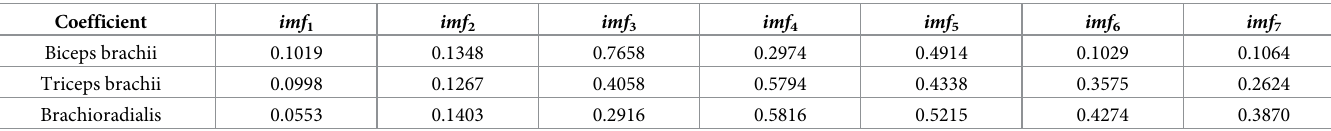
Table 1. Pearson correlation between signals of the biceps brachii, triceps brachii, and brachioradialis muscles and their IMFs after EMD decomposition.